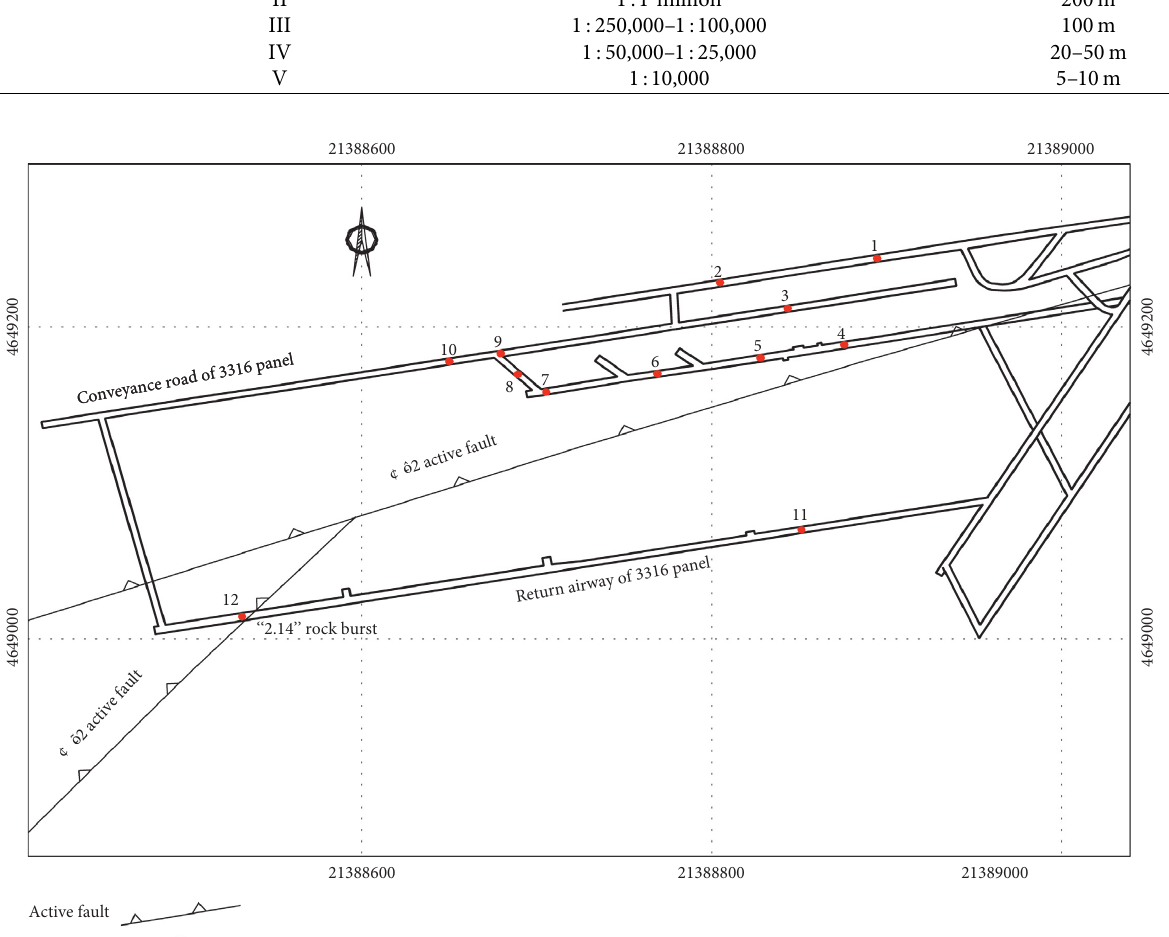
Figure 3: Positional relationships between 2.14 rock burst and fault structure in Sunjiawan Coal